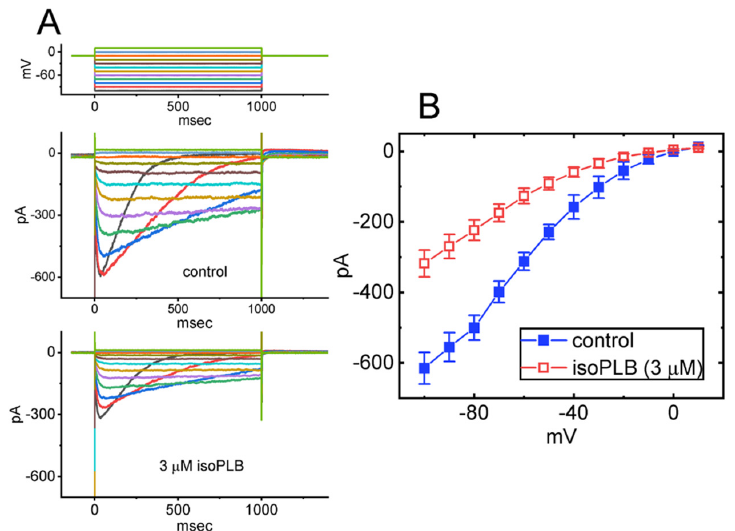
Figure 9. Effect of isoPLB on I K(erg) obtained in MA-10 Leydig tumor cells. Similar to the experiments above conducted in GH 3 cells, we immersed cells in a high-K + , Ca 2+ -free solution, and we filled the recording pipette with a K + -enriched solution. ( A ) Superimposed current traces obtained in the control (upper) and during MA-10-cell exposure to 3 μ M isoPLB (lower). The I K(erg) was evoked by the voltage-clamp protocol (indicated in the top part). ( B ) Average I–V relationship of the peak component of I K(erg) in the absence (solid blue squares) and presence (open red squares) of 3 μ M isoPLB measured from MA-10 cells (mean ± SEM; n = 7). We measured the current amplitude at the start of each voltage pulse. The analyses with or without the addition of isoPLB measured at different levels of membrane potentials were performed with ANOVA-2 ( p < 0.05).